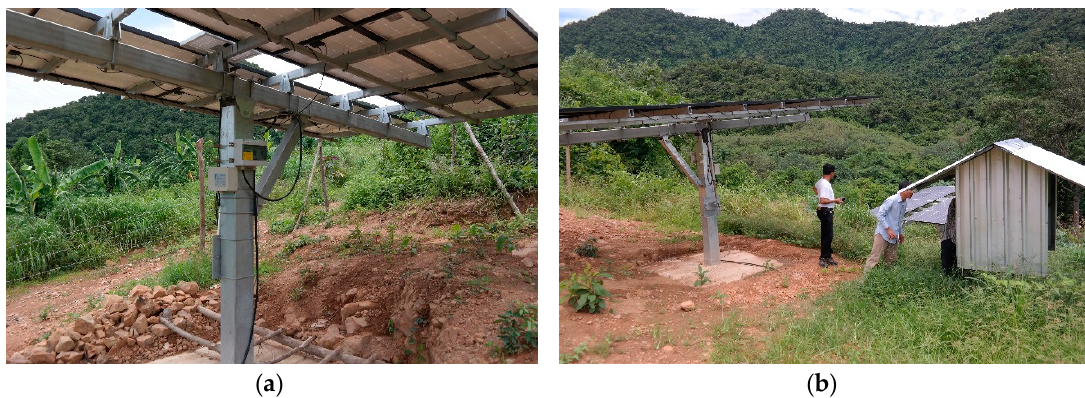
Figure 7. Closed-up view of the solar trackers installed under the PV panels (photos by the authors): ( a ) the automatic solar tracking system; ( b ) the control house. Table 3. Characteristics of the monocrystalline silicon PV panel JKM240M-60 (240 W).